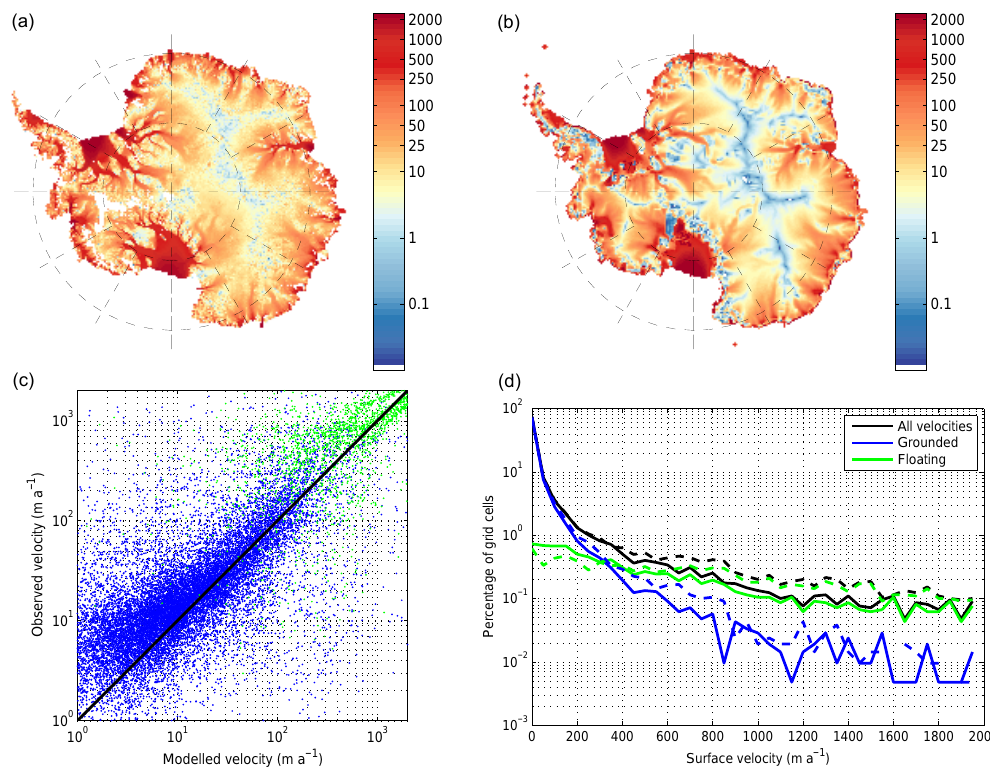
Figure 5. Observed (a) and modelled (b) ice sheet surface velocities after optimization (ma − 1 ); point-by-point scatterplot of modelled and observed (Rignot et al., 2011) ice sheet (blue) and ice shelf (green) velocities (c) ; histogram of velocity distribution of observed (dashed) and modelled (solid) velocities. Each of the bins contains a velocity range of 50ma − 1 (d) .